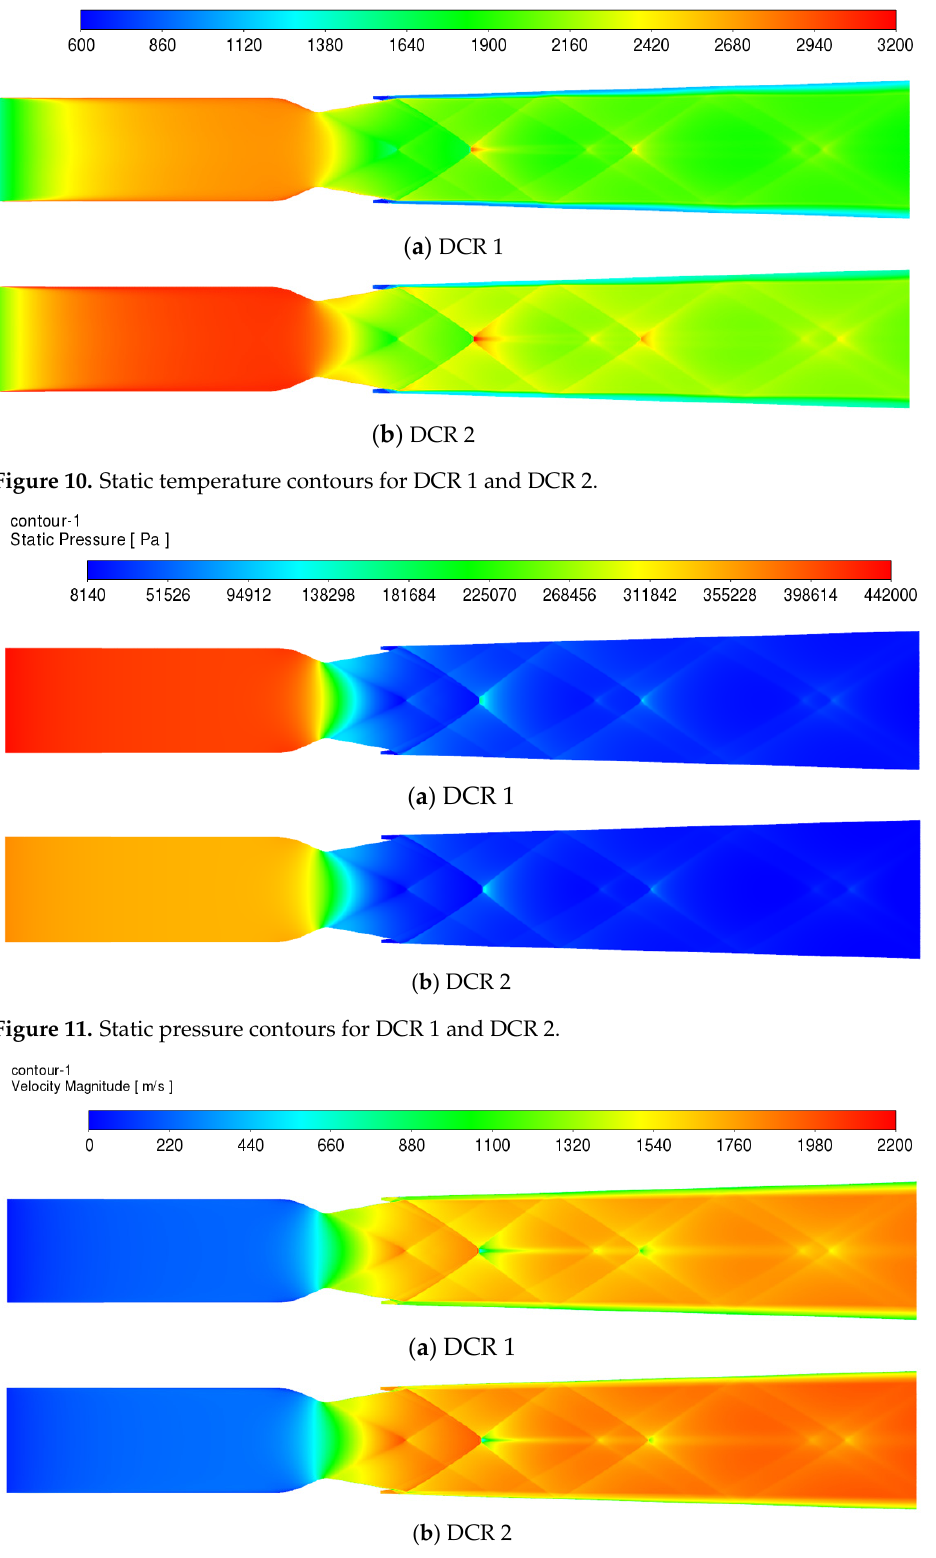
Figure 12. Velocity magnitude contours for DCR 1 and DCR 2.